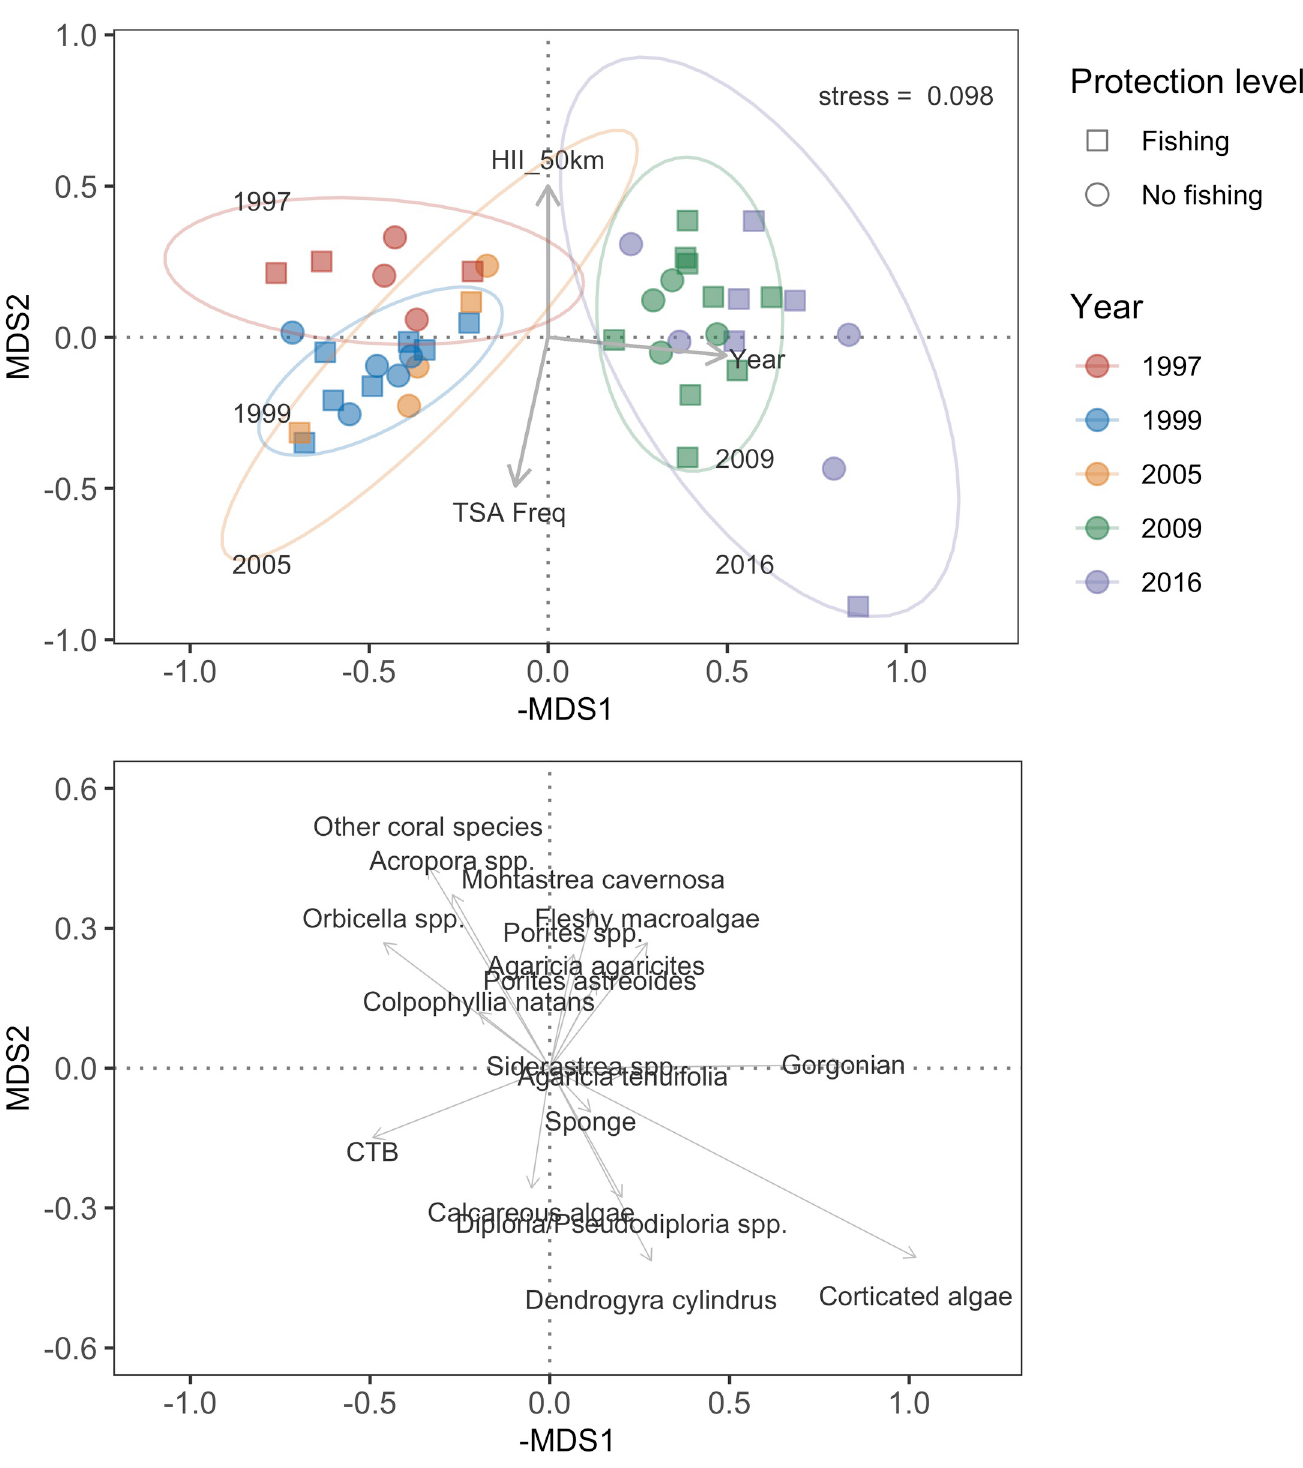
Fig 7. Non-metric multidimensional scaling (MDS) plot depicting taxon-level cover data. In the top panel, points represent individual sites, circles are fishing sites, and squares are no-fishing sites. Data are colored by year. Arrows represent the fitted loadings scores for Year, TSA_Freq, and HII_50km. In the bottom panel, the arrows and labels represent the loadings of specific benthic categories loadings. The Bray–Curtis dissimilarity matrix was used and the stress value was 0.098.